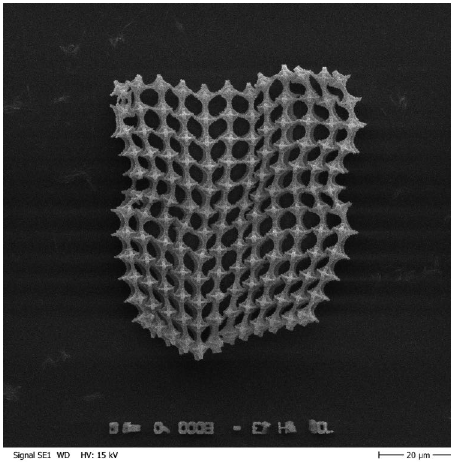
Figure 3. Structure developed with ethanol